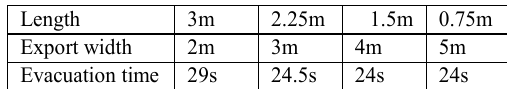
Figure 4. Evacuation time change with angle α